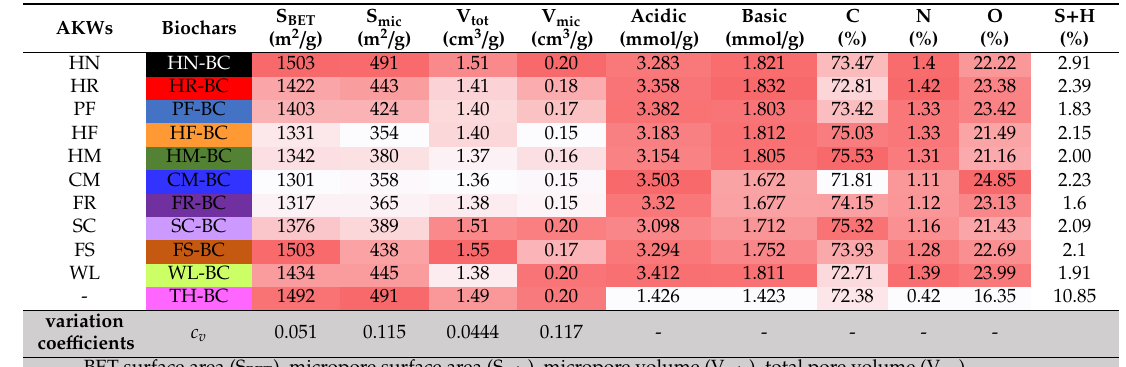
Table 1. Textural parameters, amount of acidic and basic functional groups, and elemental compositions of the AKWs-BC and TH-BC.